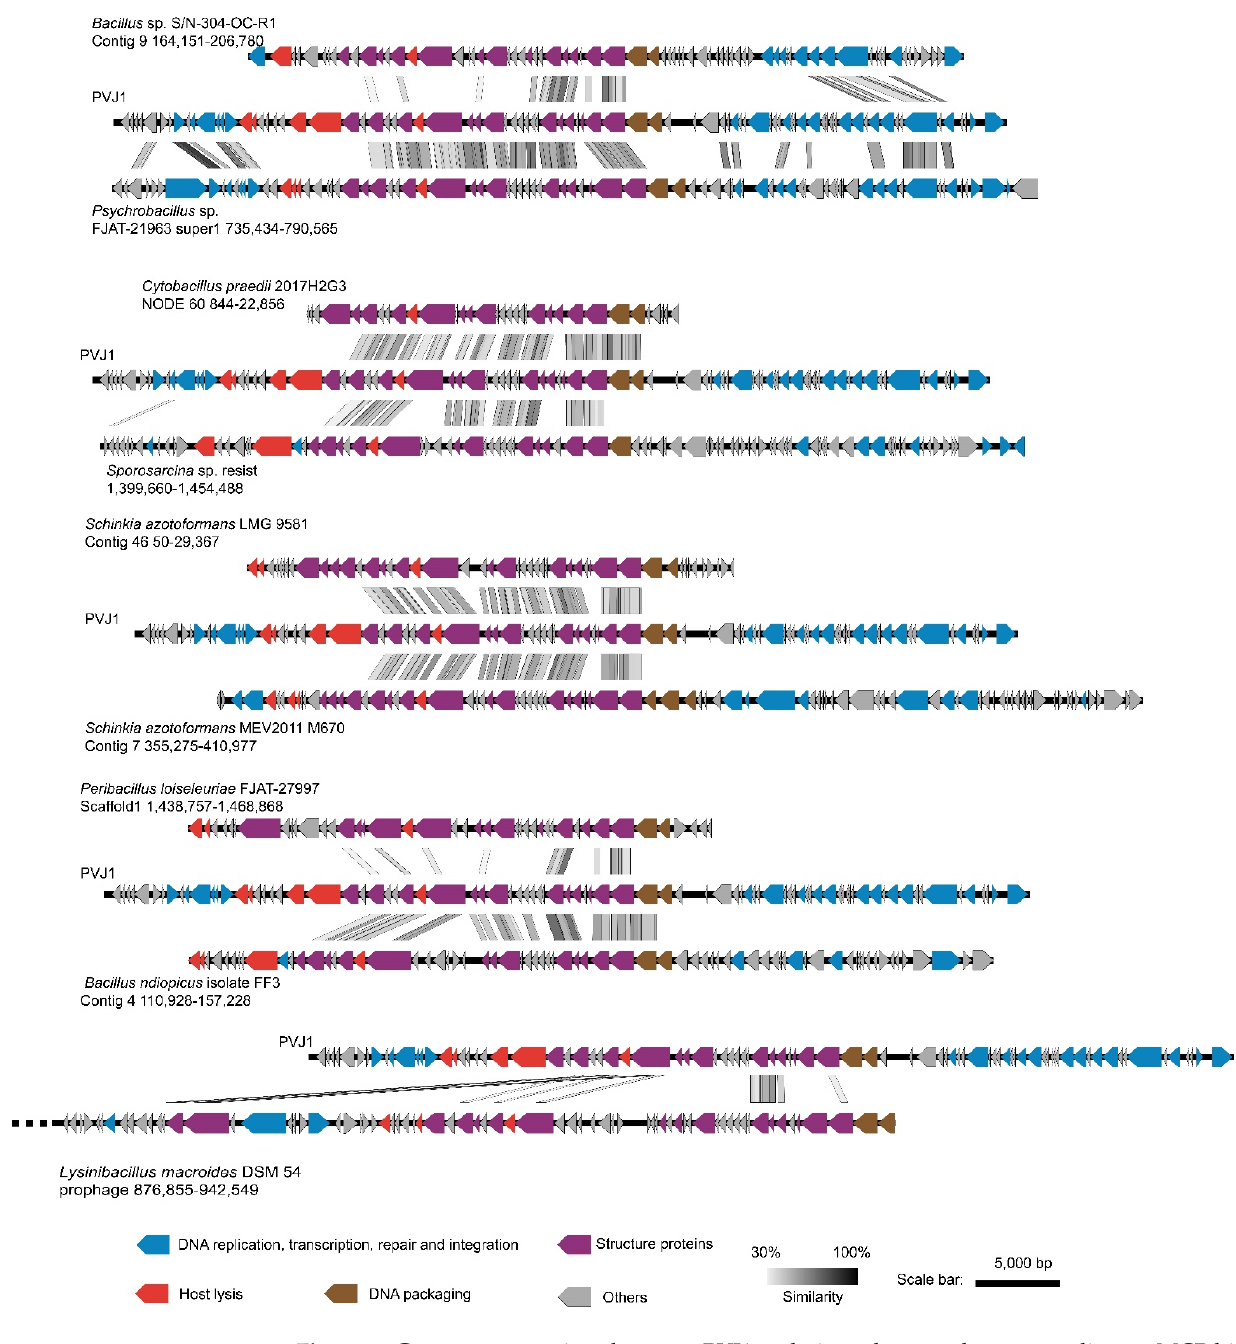
Figure 3. Genome comparison between PVJ1 and nine other prophages encoding an MCP highly similar to that of PVJ1. ORFs with putative functions are color coded as indicated. The nine prophage genomes used for synteny analysis include Bacillus sp. S/N-304-OC-R1 Contig 9 164,151–